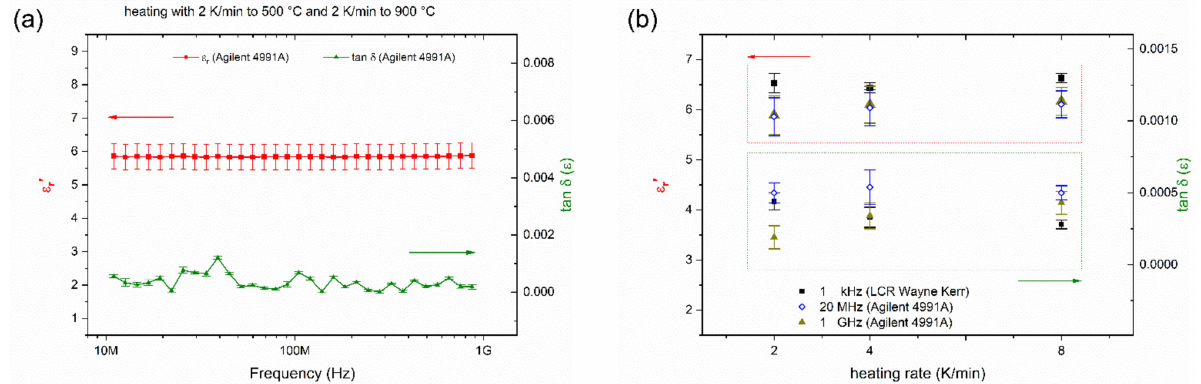
Figure 5. Permittivity ε r and loss tangent tan δ vs. frequency for CT708 sintered at 900 ◦ C, heating rate 2 K/min ( a ), and vs. heating rate ( b ).